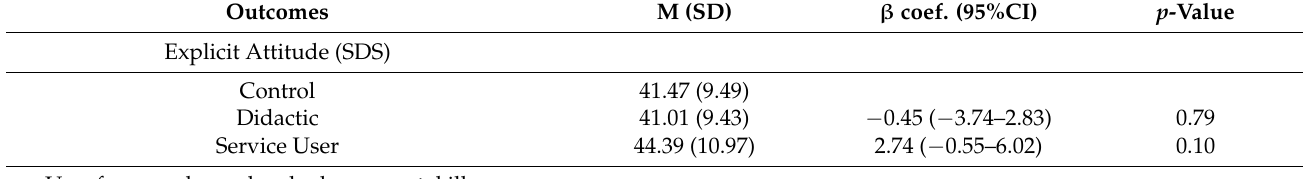
Table 5. Effects of didactic and service user video interventions versus no video (control group) on negative stigmatizing attitudes and increased knowledge about mental